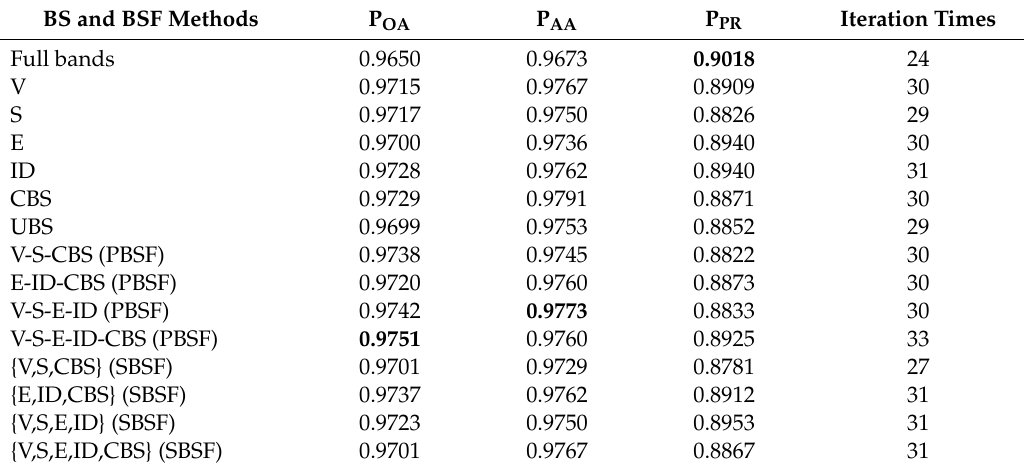
Table 9. P OA , P AA , P PR and the number of iterations calculated by ICEM using full bands and the bands selected in Table 7 for Purdue’s